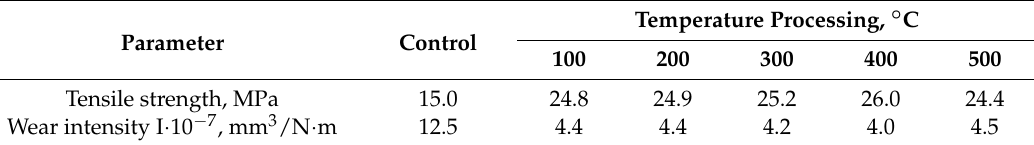
Table 7. Properties of CFRP at thermomechanical modification of grinding fiber on vacuum conditions (P = 550 ± 10 mm